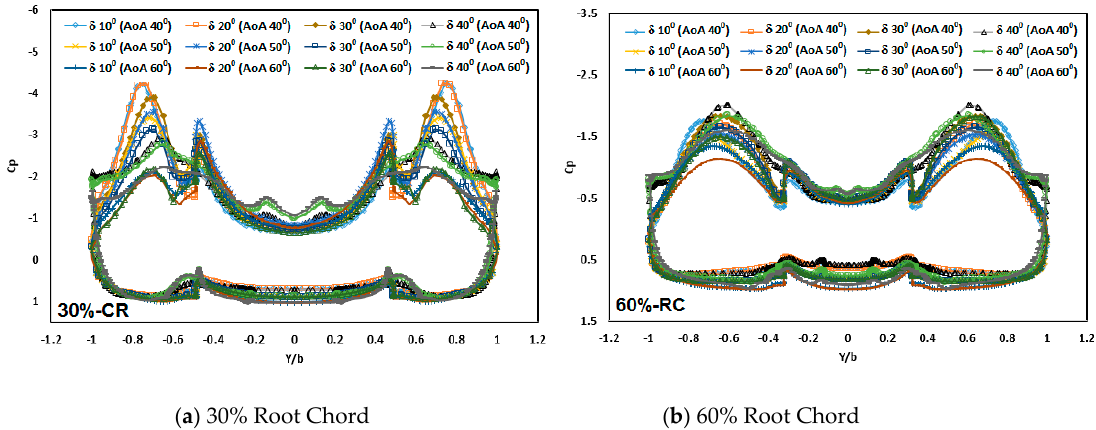
Figure 7. Surface pressure distribution (SPD or Cp ) at A0A 40°, 50°, and 60° for deflection angles δ = 10°, 20°, 30°, and 40°.